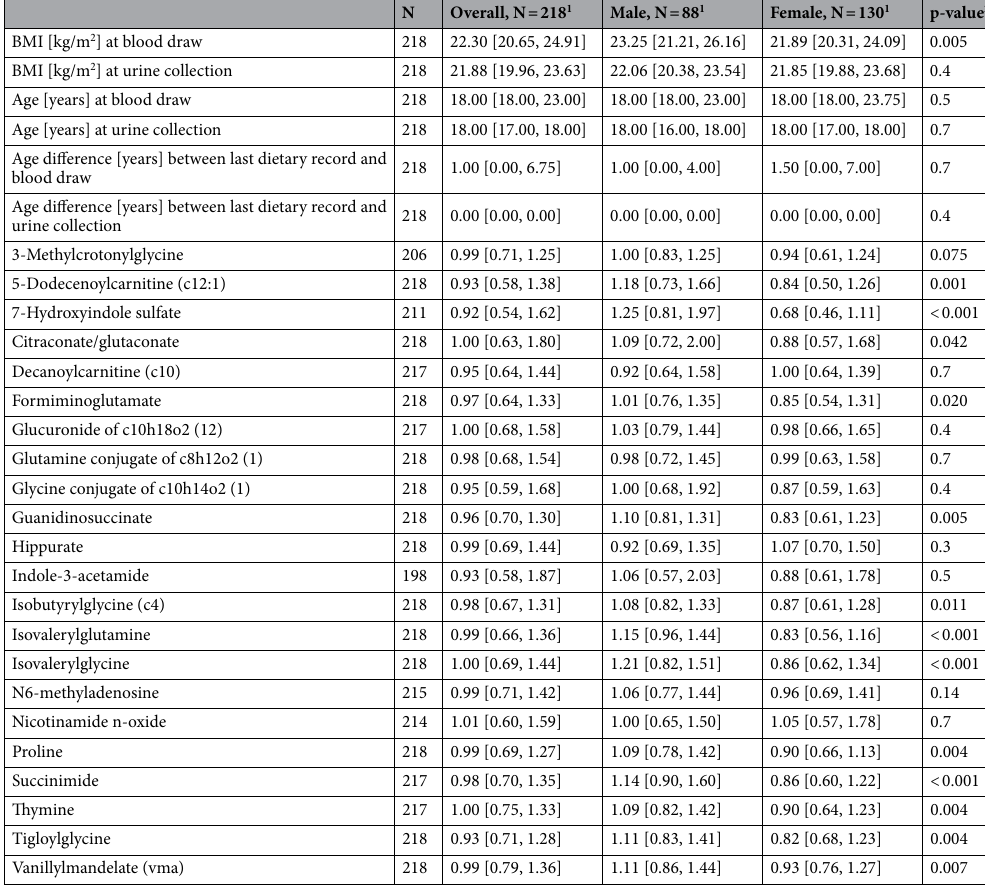
Table 2. Characteristics and markers of metabolic health of 218 DONALD participants. 1 Median [IQR]. 2 Wilcoxon rank sum test Males VS Females. Unknown metabolites are not